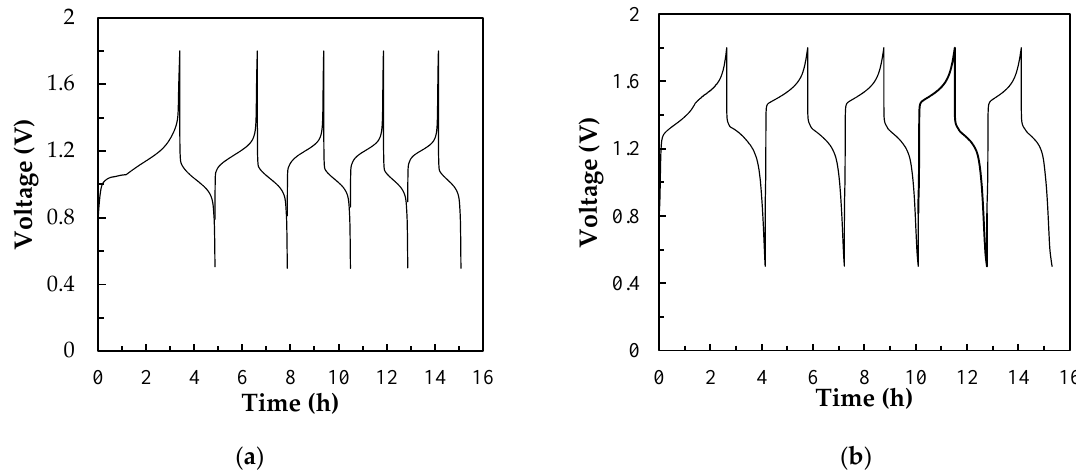
Figure 8. The charge/discharge diagrams of a Ce/ascorbic acid/I RFB system with 1.0 M Ce(NO 3 ) 3/ 2.0 M CH 3 SO 3 H as a positive electrolyte, 1.0 M I 2 /0.25 M ascorbic acid/2.0 M H 2 SO 4 as a negative electrolyte and C–TiO 2 –PdO composite electrodes as positive/negative electrodes, with two serpentine-type flow channels at a current density of 20 mA/cm 2 and 20 mL of electrolyte solutions with ( a ) N-117 ( b ) modified N-117–SiO 2 –SO 3 H as a separation membrane.